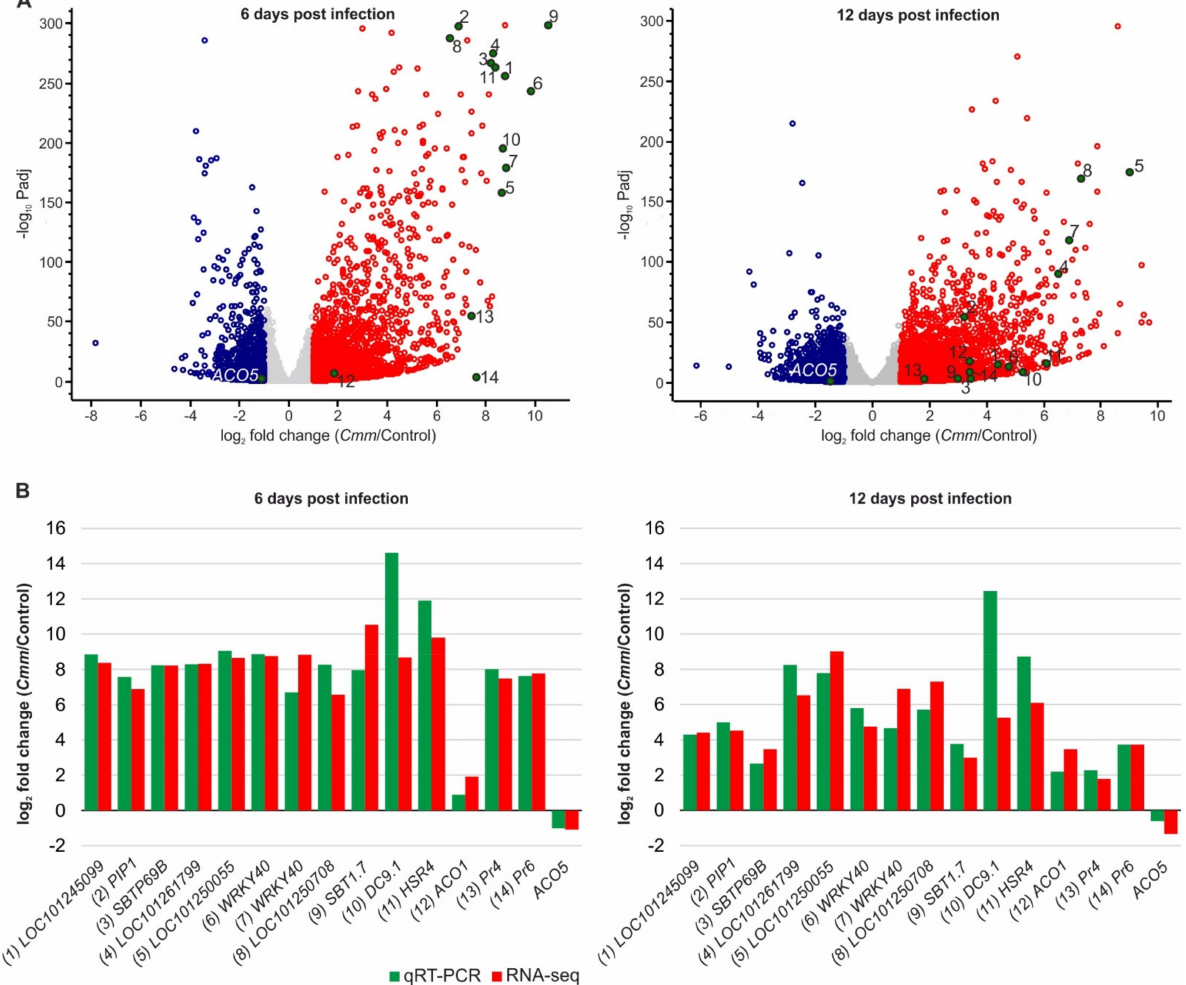
Figure 3. Differentially expressed genes of Cmm infected tomato stems. ( A ) Volcano plots of differentially expressed genes (DEGs) identified by RNA-seq analysis of Cmm infected versus control plants at 6 (left panel) and 12 dpi (right panel). Red and blue dots indicate up- and down- regulated genes, respectively. Green dots with numbers indicate genes selected for qRT-PCR validation of the transcriptome analysis results. ( B ) Comparative analysis of gene transcription results derived from qRT-PCR and RNA-seq transcriptome analysis. Green bars represent the fold change value calculated by qRT-PCR analysis as the log2 ratio between the quantitative median expression of the gene in Cmm infected plants relative to the control (n = 4). Red bars represent the fold change value expressed as the log2 between the ratio of the mean FPKM gene expression in Cmm infected and control plants obtained by RNA-seq analysis (n = 3). Positive values correlate with upregulated gene expression, whereas negative values with downregulation of gene ( ACO5 )